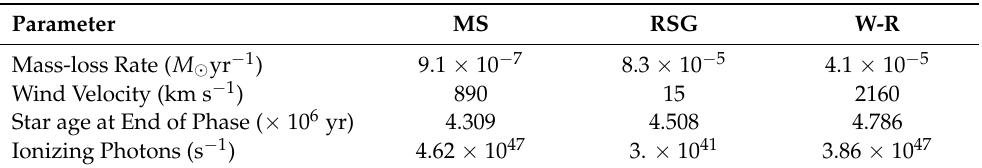
Table 1. The values of relevant parameters in the various phases of the evolution of a 40 M (cid:12) star, taken from